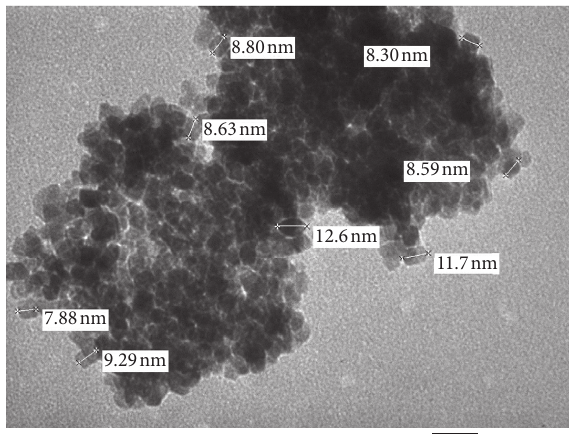
2 , C-TiO 2 , N-TiO 2 ,